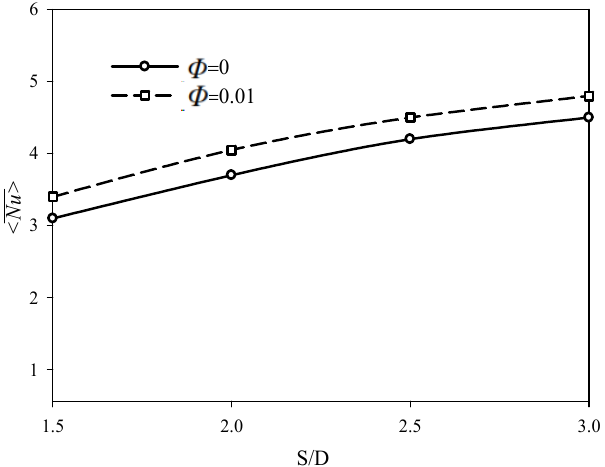
Figure 9. Variation of mean Nusselt number with space ratios for Re = 100, d p = 30 nm, and two values of solid volume fraction of nanoparticles.